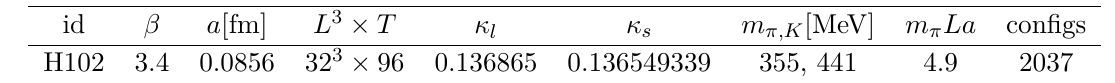
Table 3 . Details of the CLS ensemble which we use for the evaluation of the two-current matrix elements. Our simulation includes 990